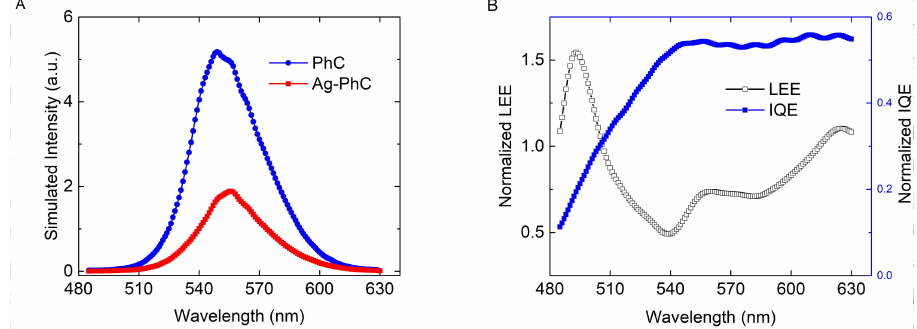
Figure 5. ( A ) Simulated PL spectra for Ag–PhC and PhC samples, ( B ) internal quantum